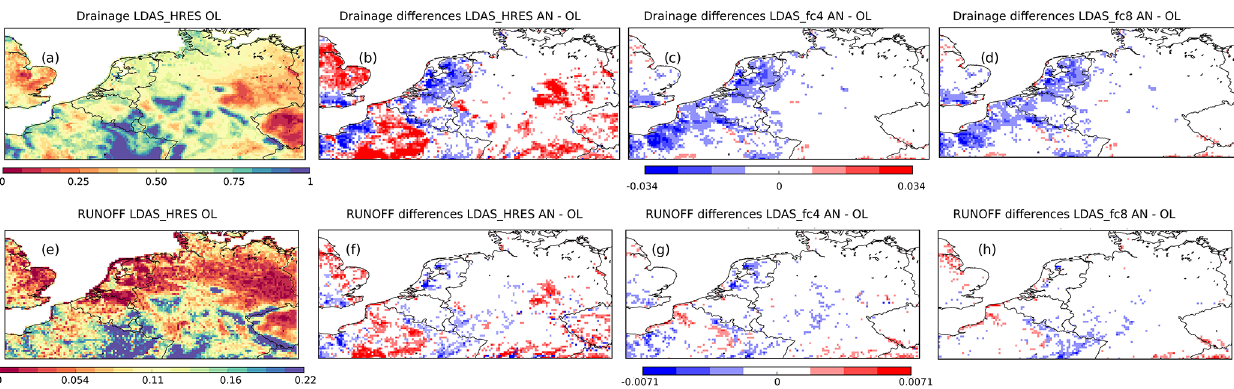
Figure 17. (a) Drainage values for LDAS_HRES open-loop over 2017–2018 for the WEUR domain; (b) drainage differences between LDAS_HRES analysis and open-loop. (c) and (d) : same as (b) between LDAS_fc4 initialized by the analysis and LDAS_fc4 initialized by the open-loop and between LDAS_fc8 initialized by the analysis and LDAS_fc8 initialized by the open-loop. Bottom row: same as the top row for runoff. Units are kgm − 2 d − 1